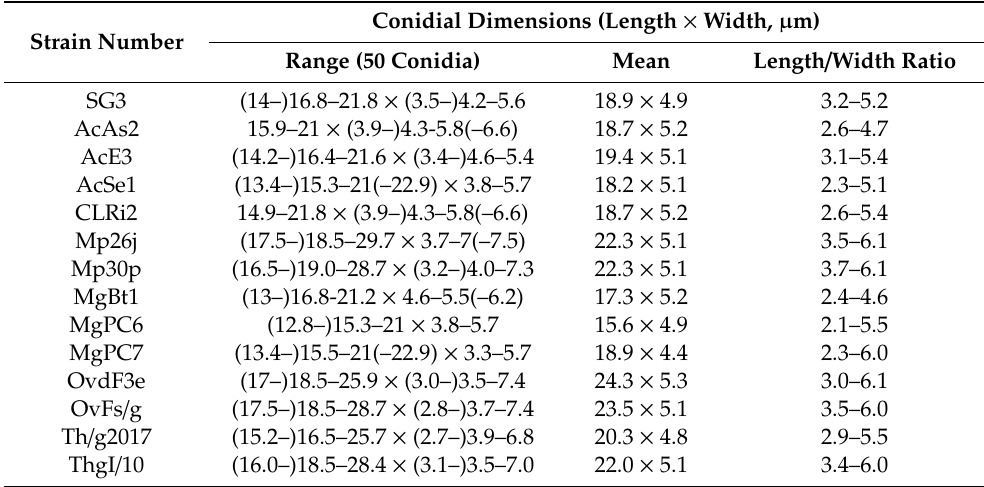
Table 4. Morphological features of B. dothidea isolates from Lamiaceae examined in this